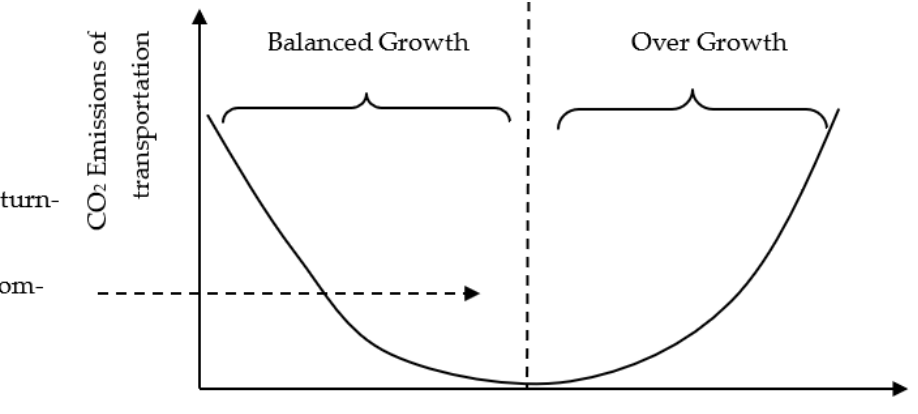
Figure 1. Theoretical Framework (Inverted U-Shaped EKC).